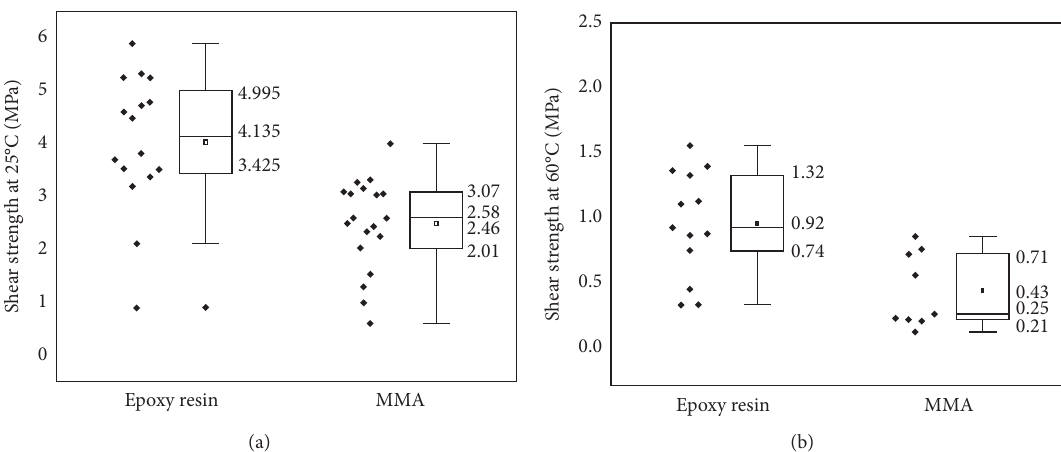
Figure 14: Shear strength comparison of resin-based waterproof adhesive layer: (a) shear strength at 25 ° C; (b) shear strength at 60 ° C.